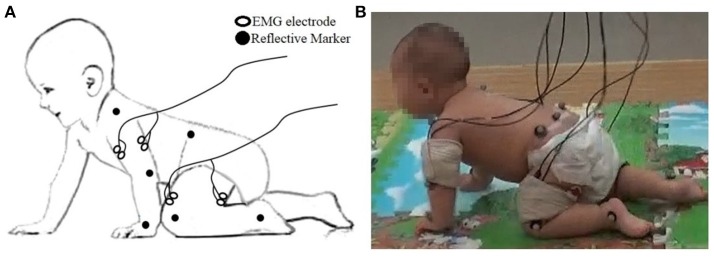
(A) The placement of the EMG electrode and reflective markers; (B) Snapshot of data collection.